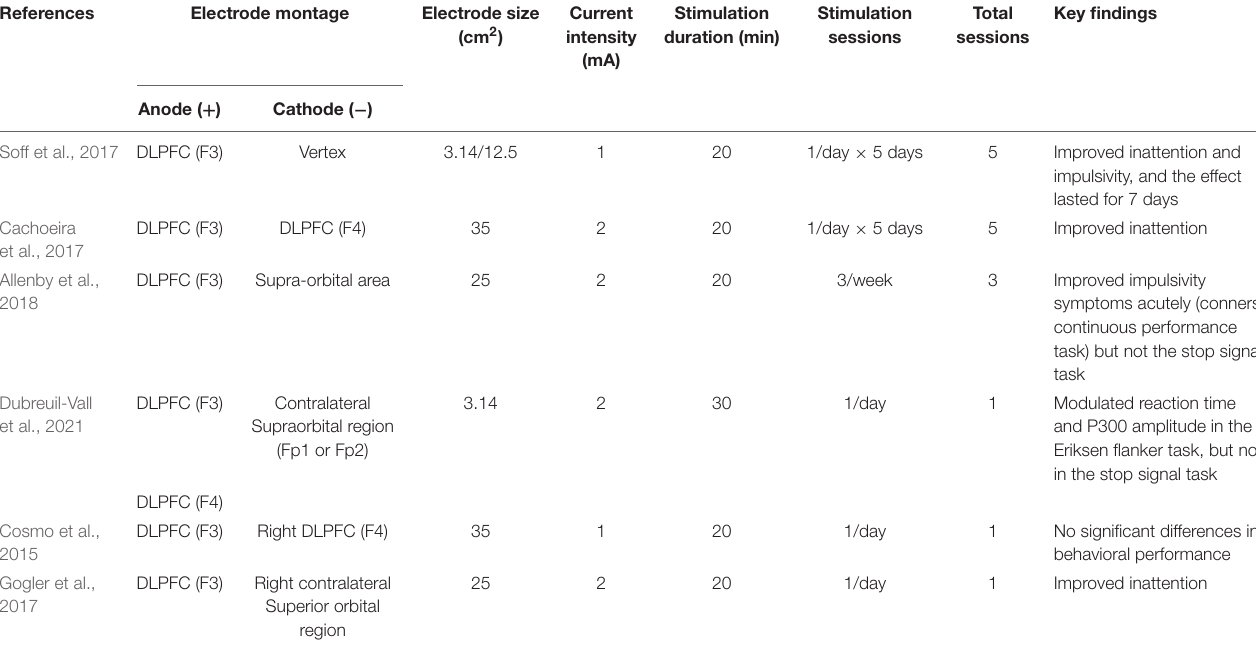
TABLE 4 | Effects of DLPFC tDCS on ADHD.